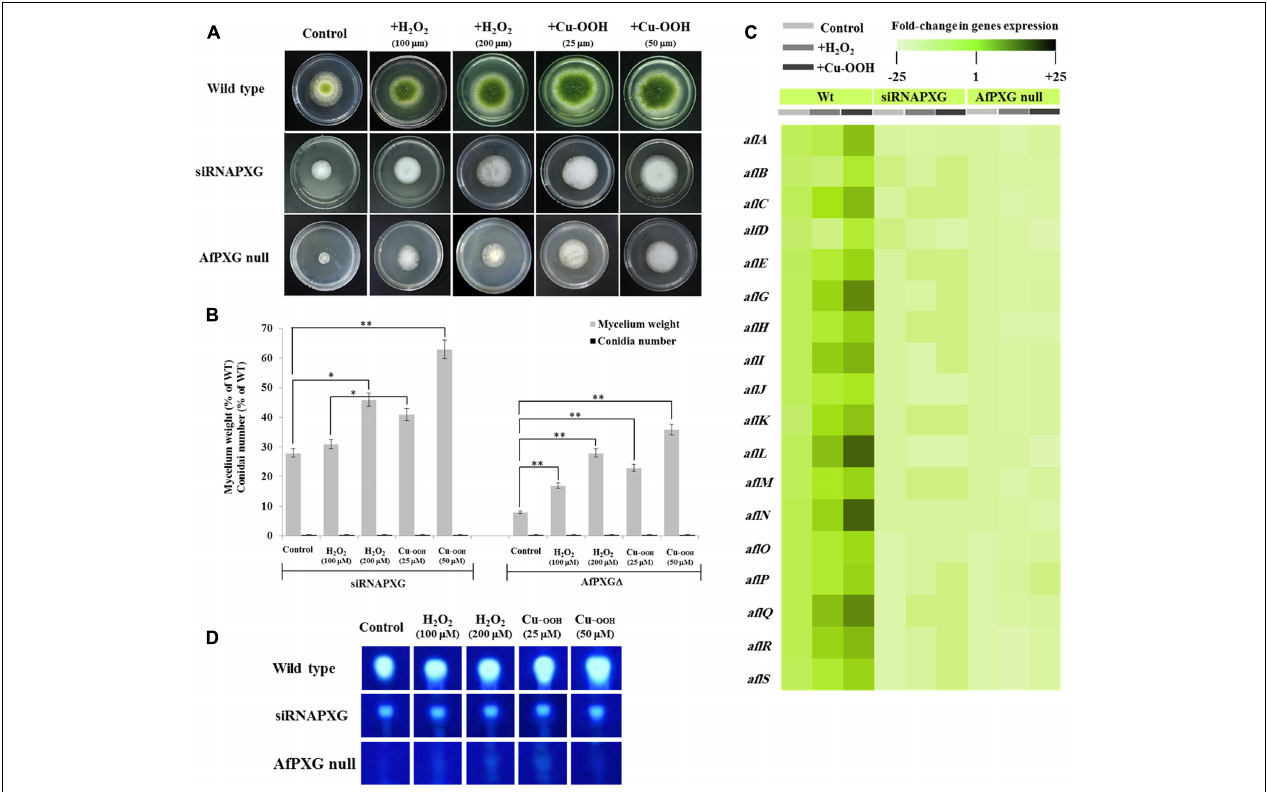
FIGURE 2 | Increasing oxidative status does not restore the AfPXG -mutant phenotype. (A) Effect of H 2 O 2 and cumene hydroperoxide (Cu-OOH) on the morphology of fungal phenotypes grown on PDA plates for 4 days at 28 ◦ C. Fungal growth was incubated with H 2 O 2 and Cu-OOH at the indicated concentration. (B) Evaluation of fungal biomass (light-gray columns) and conidia number (black columns) for both lines, siRNAPXG2 and AfPXG (cid:49) . Fungal biomass from each of the AfPXG -deficient lines exposed to H 2 O 2 or Cu-OOH was significantly different from those of non-treated lines when analyzed by t -test ( ∗ P < 0.05; ∗∗ P < 0.01). (C) Relative quantification of transcript levels of AFB1-biosynthesis genes in AfPXG -deficient lines as a function of treatments with H 2 O 2 (200 mM) or Cu-OOH (50 mM) compared with controls. For each gene, the transcript level was evaluated by qRT-PCR as described in Section “Materials and Methods.” Three measurements were taken in three cDNAs prepared from three individual fungal growth for each treatment. The color scale (white–green–black) indicates relative changes of transcript abundance of –25-, 1-, and +25-fold, respectively. For each gene, the expression level in WT unexposed to H 2 O 2 or Cu-OOH was defined as 1, and the corresponding abundance changes under treatments were calculated directly using software installed in the Applied Biosystems qPCR system. (D) TLC-analysis of AFB1 produced by AfPXG -deficient lines as a function of treatment with H 2 O 2 or Cu-OOH compared with